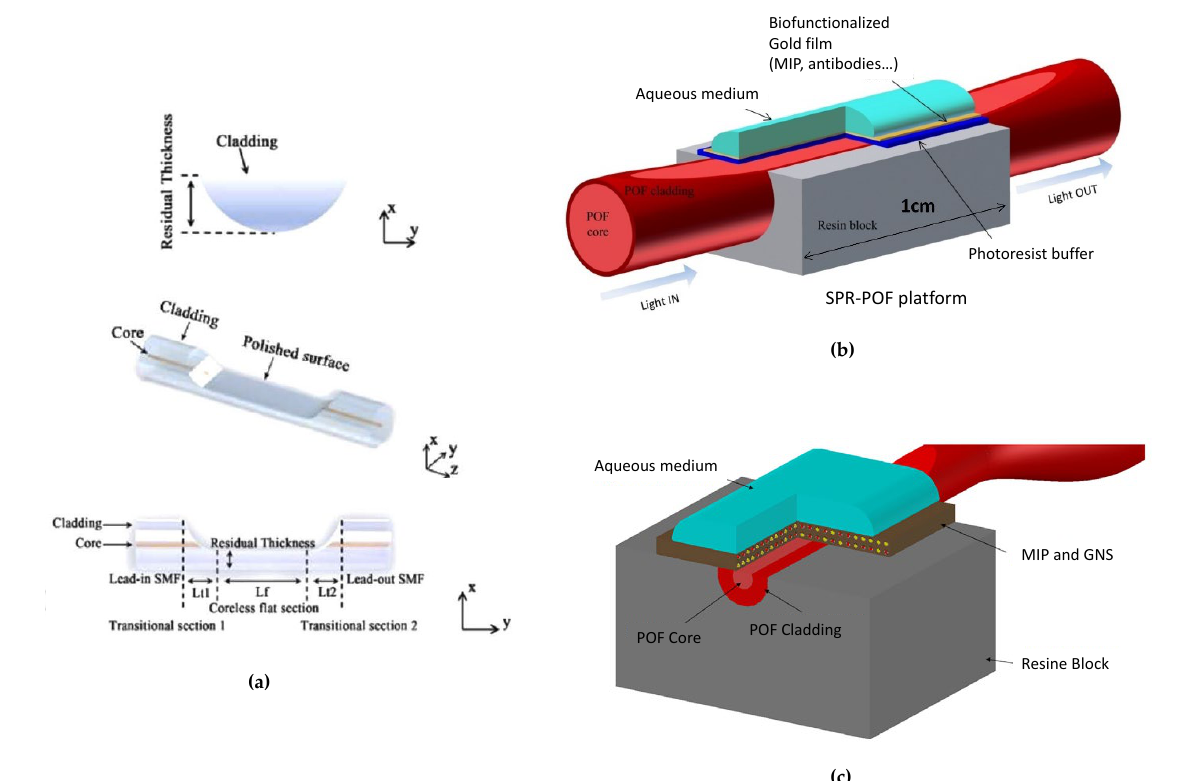
Figure 5. Schematics of D-shaped OFBs: ( a ) core-less D-shape in different perspectives (images adapted from [42]); ( b ) SPR-POF D-shaped biosensing platform (image adapted from [46]. Copy- right ©2021, with permission from Elsevier); ( c ) LSPR D-shaped tapered-POF biosensor based on gold nanostars (GNS) and MIPs (image reprinted from [47]. Copyright ©2015, with permission from Elsevier).